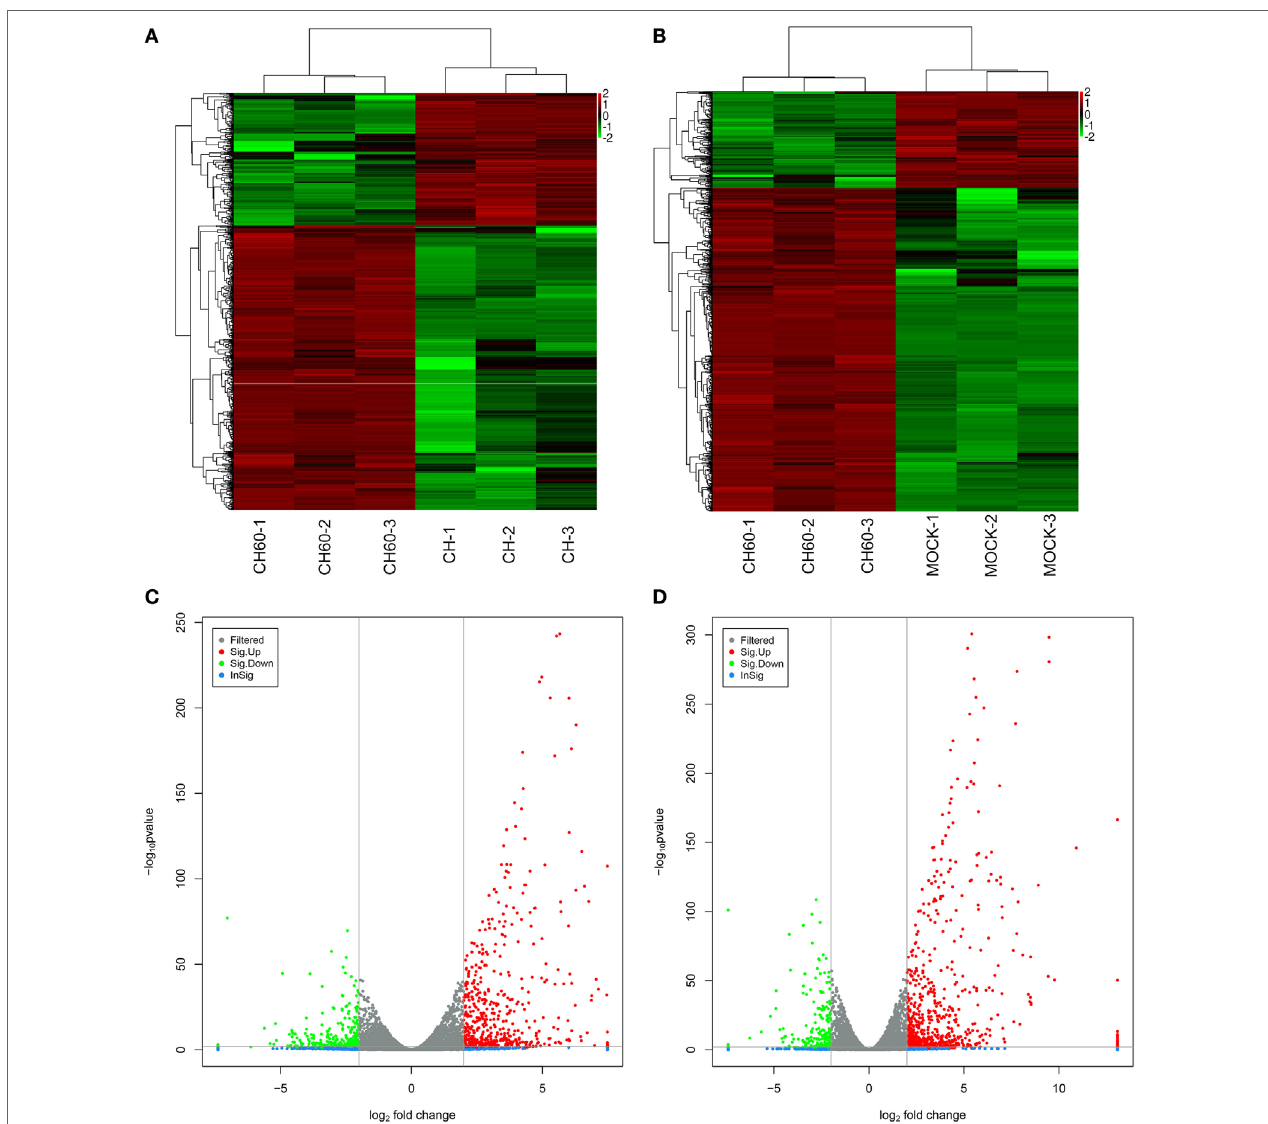
FigUre 4 | Analysis of differentially expressed genes (DEGs) of the mock, CH, and CH60 groups ( p -value < 0.01 and fold change > 4). A heatmap was used to classify the gene expression patterns, and a volcano plot displayed the number of DEGs. (a,B) The x -axis represents the experimental conditions. (c) Volcano plot of DEGs between the CH and CH60 groups. (D) Volcano plot of DEGs between the MOCK and CH60 groups. The y -axis indicates the negative logarithm of the p -value; the x -axis indicates the base 2 logarithm of fold